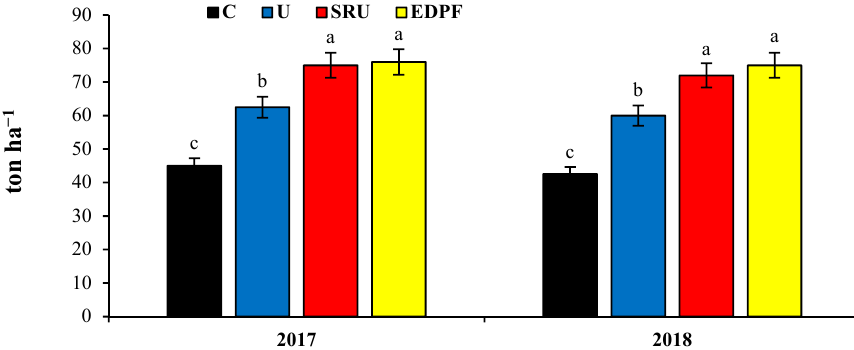
Figure 1. Effect of nitrogen forms on the total banana yield during the two growing seasons (ton ha − 1 ). C = control, U = urea, SRU = slow-release urea, and EDPF = expired dairy products fertilizer. Means ( ± standard deviation, n = 5) in the same column with different letters show significance based on Duncan’s test at p < 0.01.